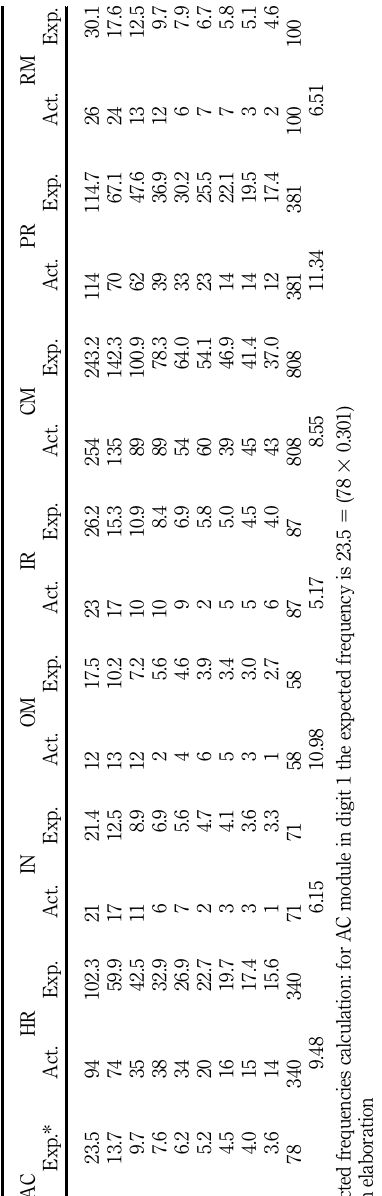
Table 6. Actual and Benford ’ s expected frequencies for each